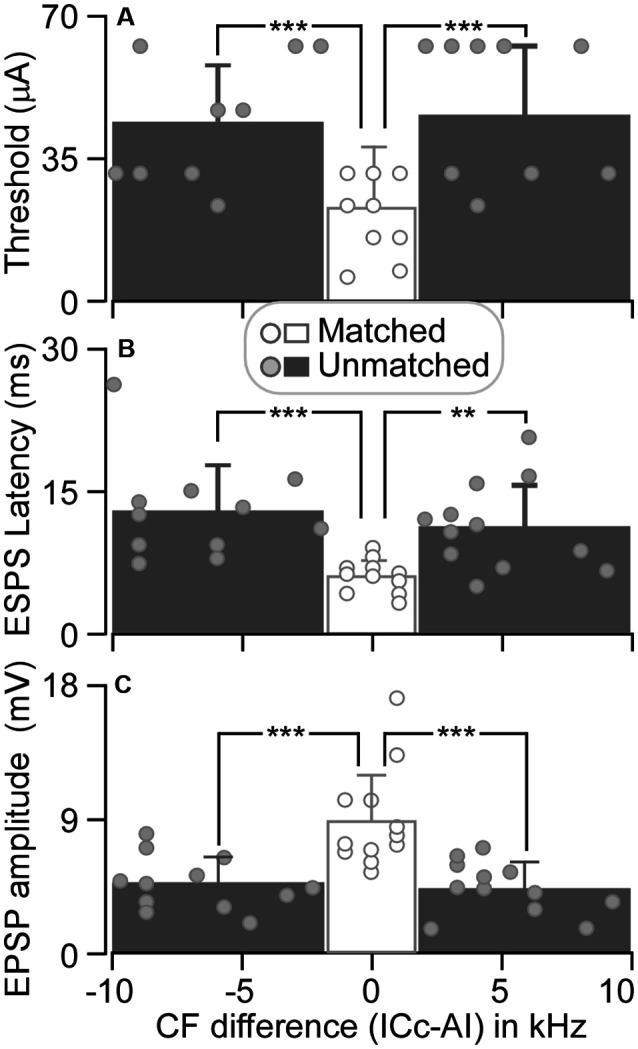
The threshold induced EPSP (A), EPSP latency (B), and amplitude (C) are plotted as the function of CF difference between ICc and AI neurons. Histograms show the averaged values of ICc neurons that had similar CFs to (middle), lower than (left), and higher than (right) those of AI neurons. **p < 0.005; ***p < 0.001.